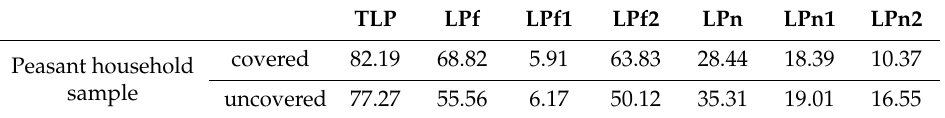
Table 2. Health insurance coverage and labor force participation rate (%) in 2013.